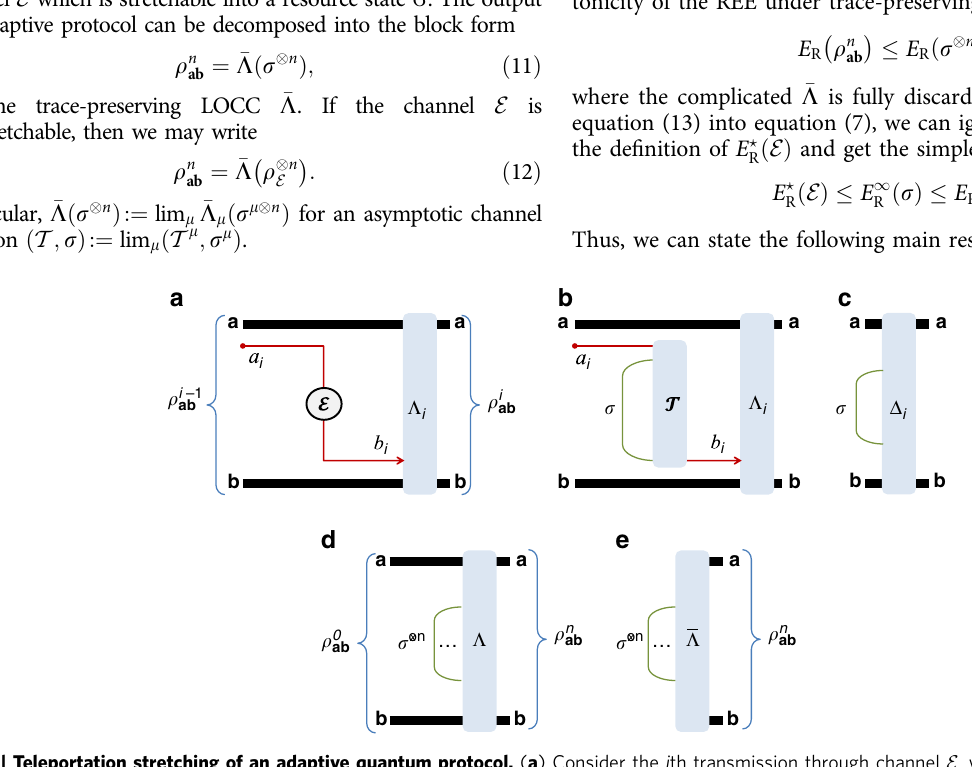
Figure 4 | Teleportation stretching of an adaptive quantum protocol. ( a ) Consider the i th transmission through channel E , where